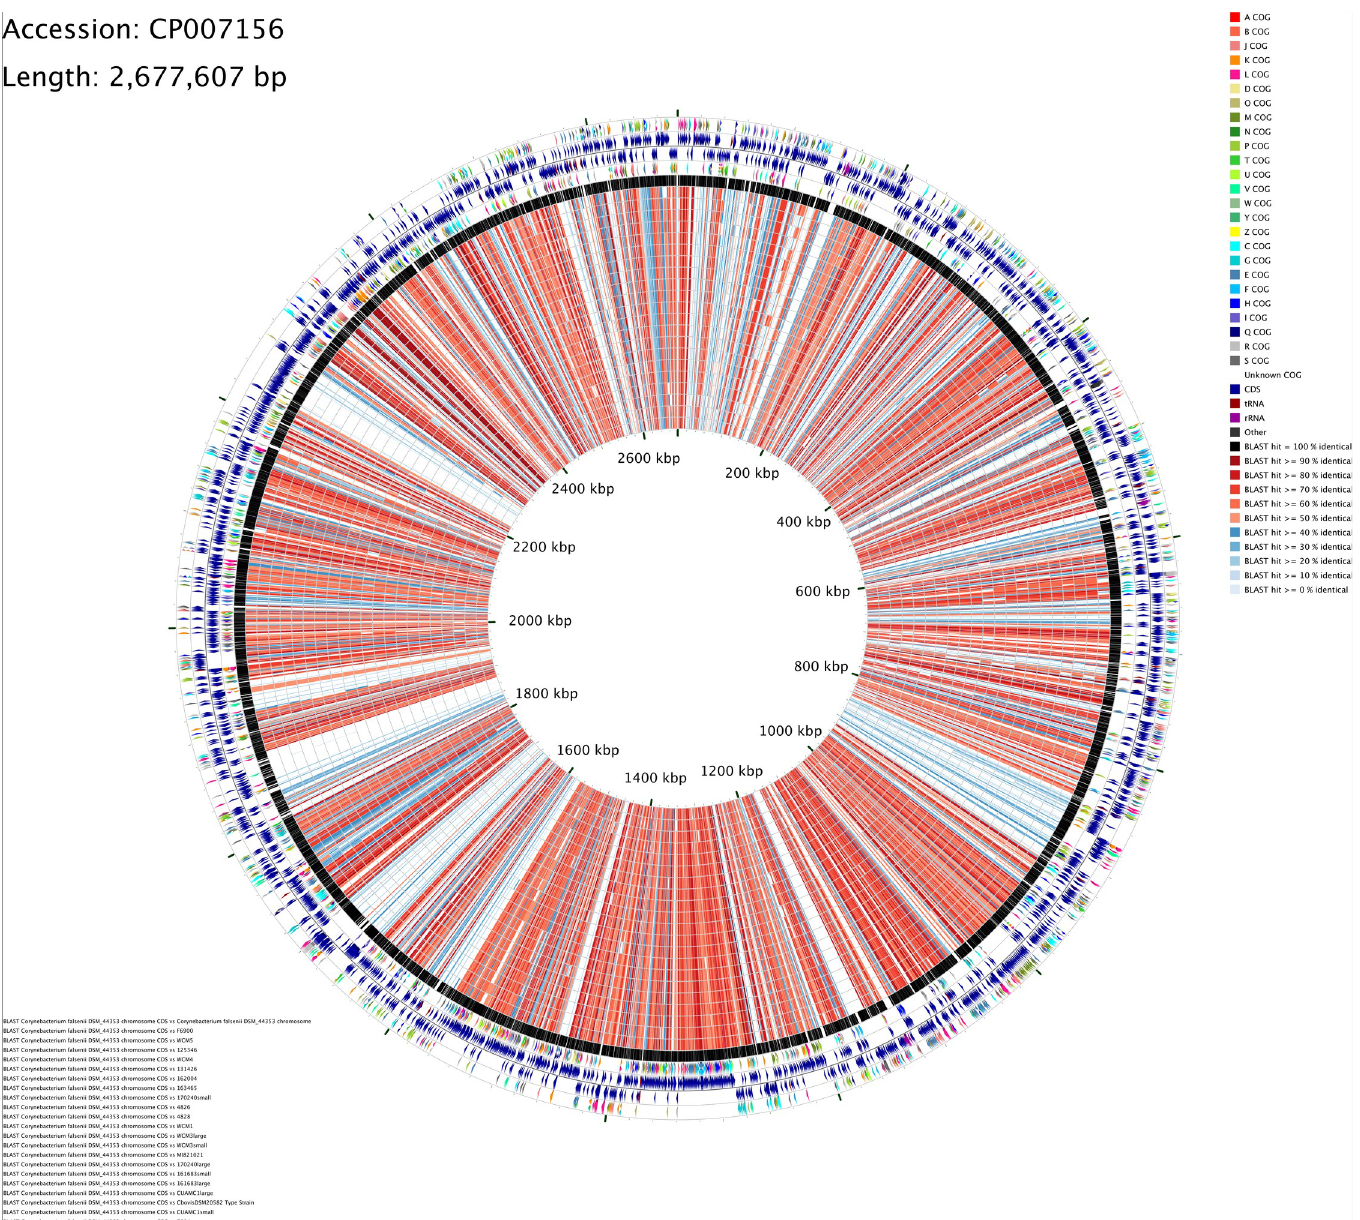
Fig 4. Comparative genomic map of 21 C . bovis isolates using the CGView Comparison Tool (CCT). All isolates were aligned using C . falsenii DSM 44353 T ’s complete genome as a reference. From the inner to the outer circle: C . bovis 7894, CUAMC1-Small, DSM 20582 T , CUAMC1-Large, 16-1683-Large, 16-1683-Small, 17-0240-Large, MI 82–1021, WCM3-Small, WCM3-Large, WCM1, 4828, 4826, 17-0240-Small, 16–3465, 16–2004, 13–1426, WCM4, 12–5346, WCM5, F6900, C . falsenii DSM 44353 T (black circle). These rings represent regions of sequence similarity detected by BLAST comparisons of DNA sequences using BLASTn searches and CDS feature translations using BLASTp conducted between the reference genome and the 21 C . bovis comparison genomes. Colored arrows represent COG functional categories. Blue arrows represent sequence features. Direction of the arrows represent either the forward or the reverse strand. CDS, coding sequences; tRNA, transfer RNA; rRNA, ribosomal